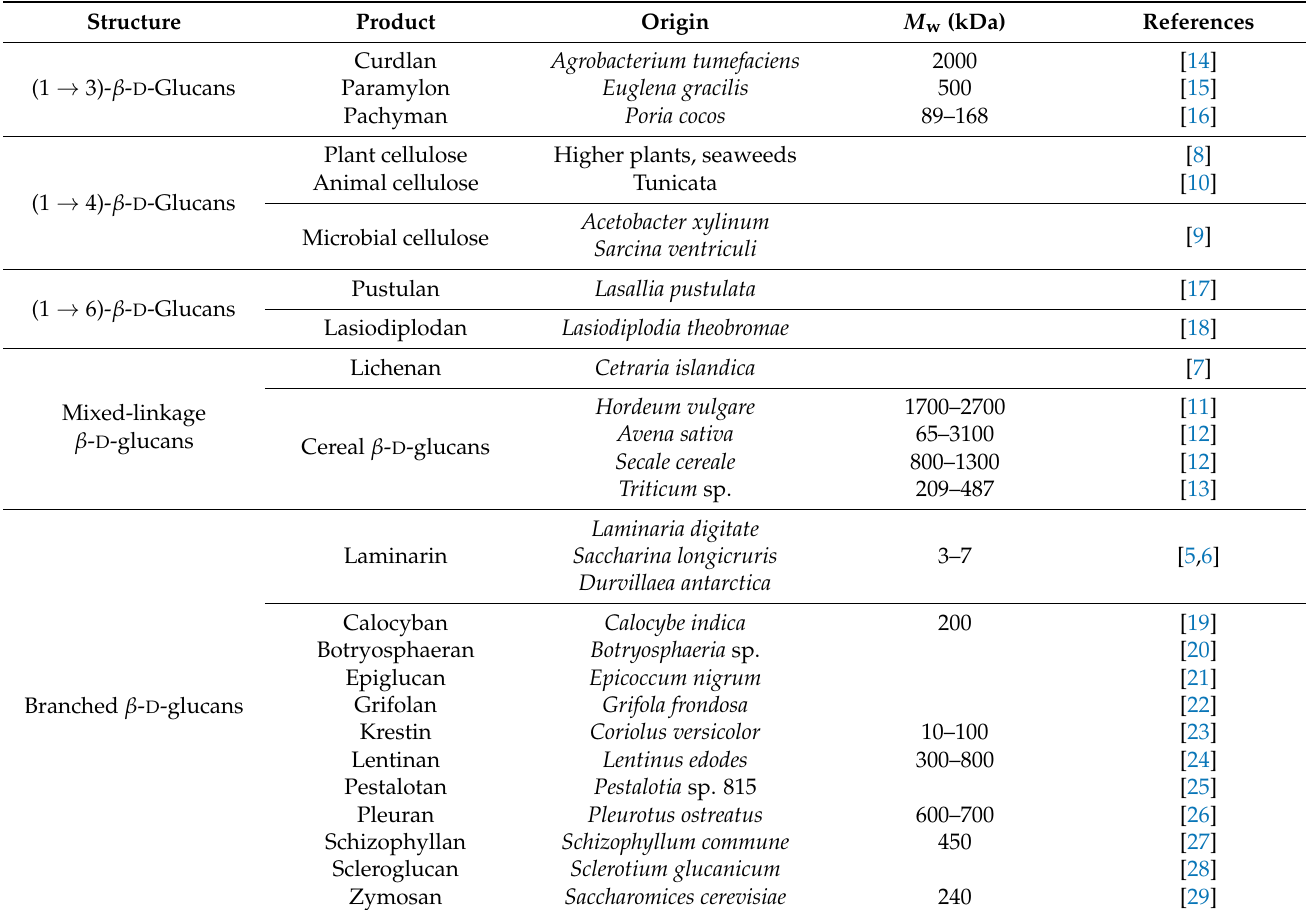
Table 1. Overview of β - D -glucans of various structure and